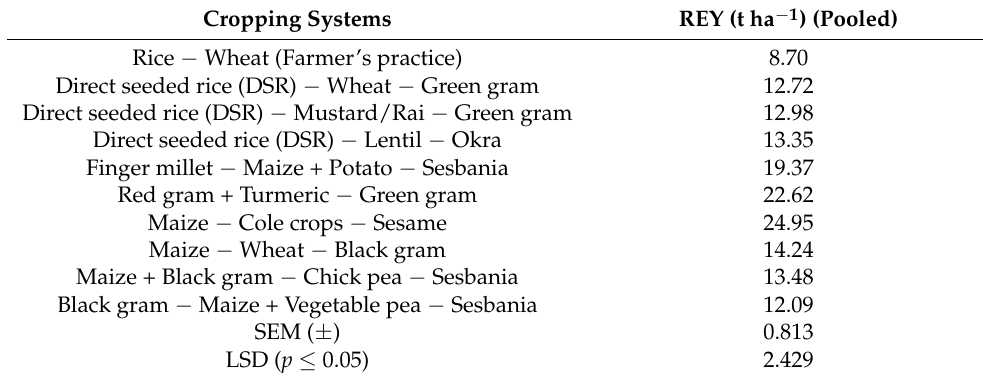
Table 4. Rice equivalent yield is affected by the diversified cropping